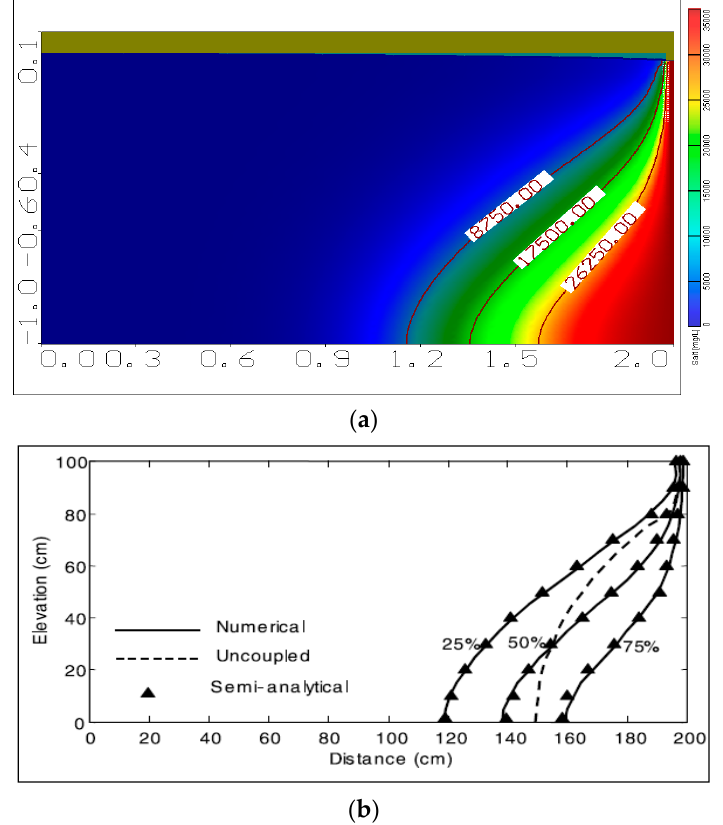
Figure 2. Comparing results of ( a ) SEAWAT (current) and ( b ) Simpson and Clement (2004) [29].